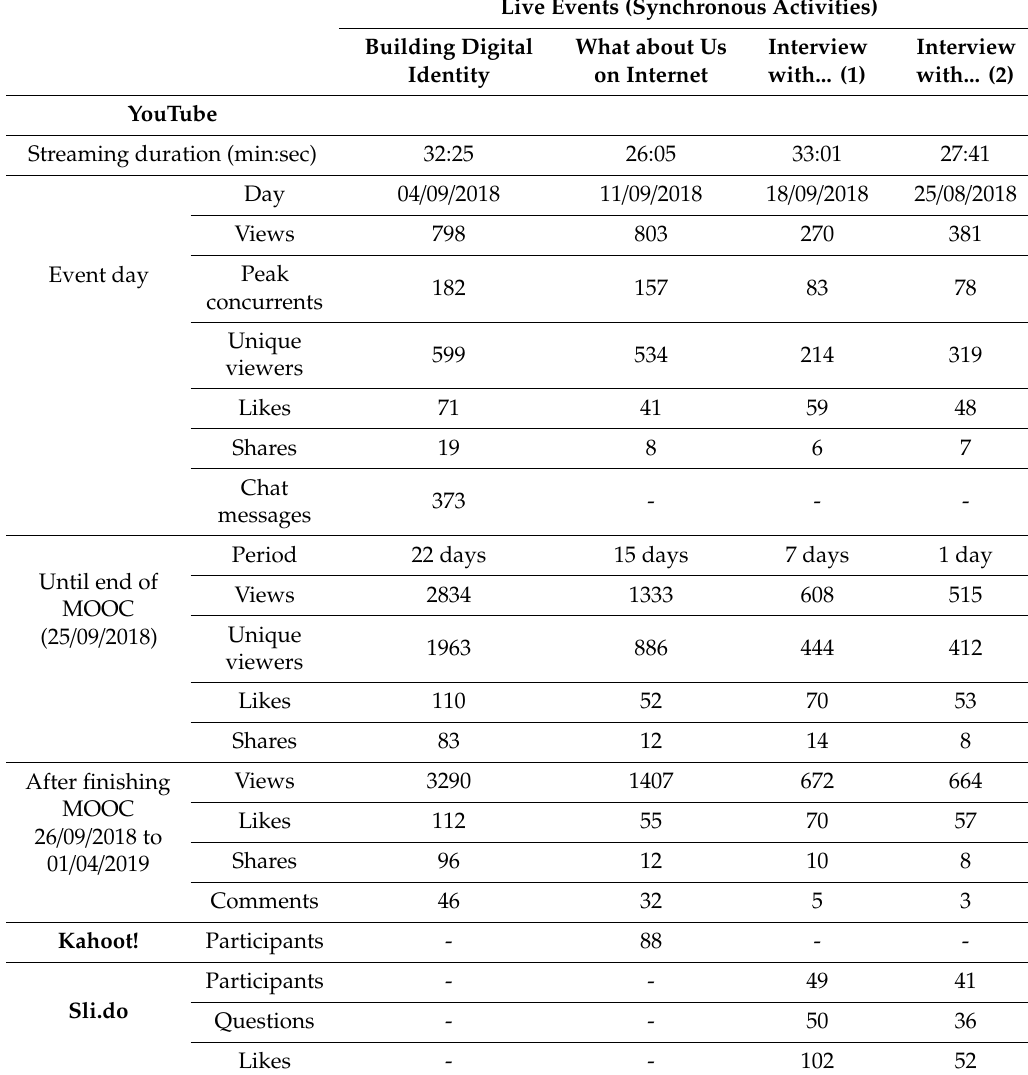
Table 3. Live events